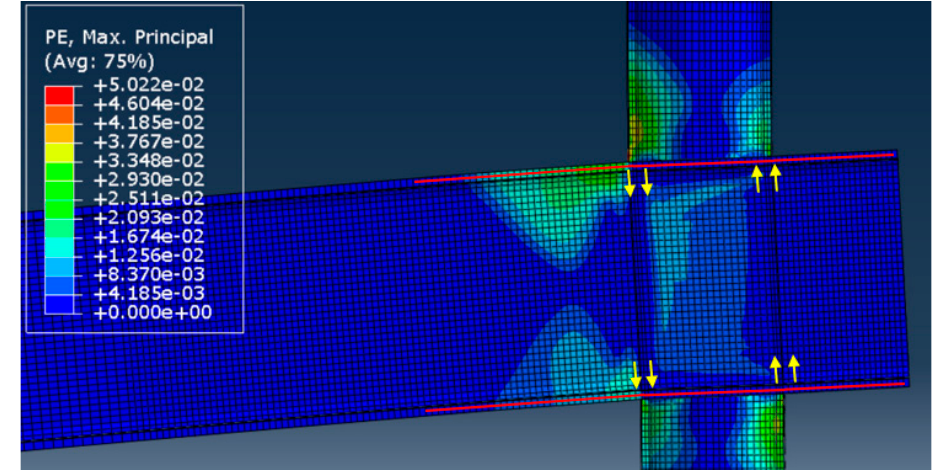
Figure 7. View-cut of a CHS column with passing-through beam connection.